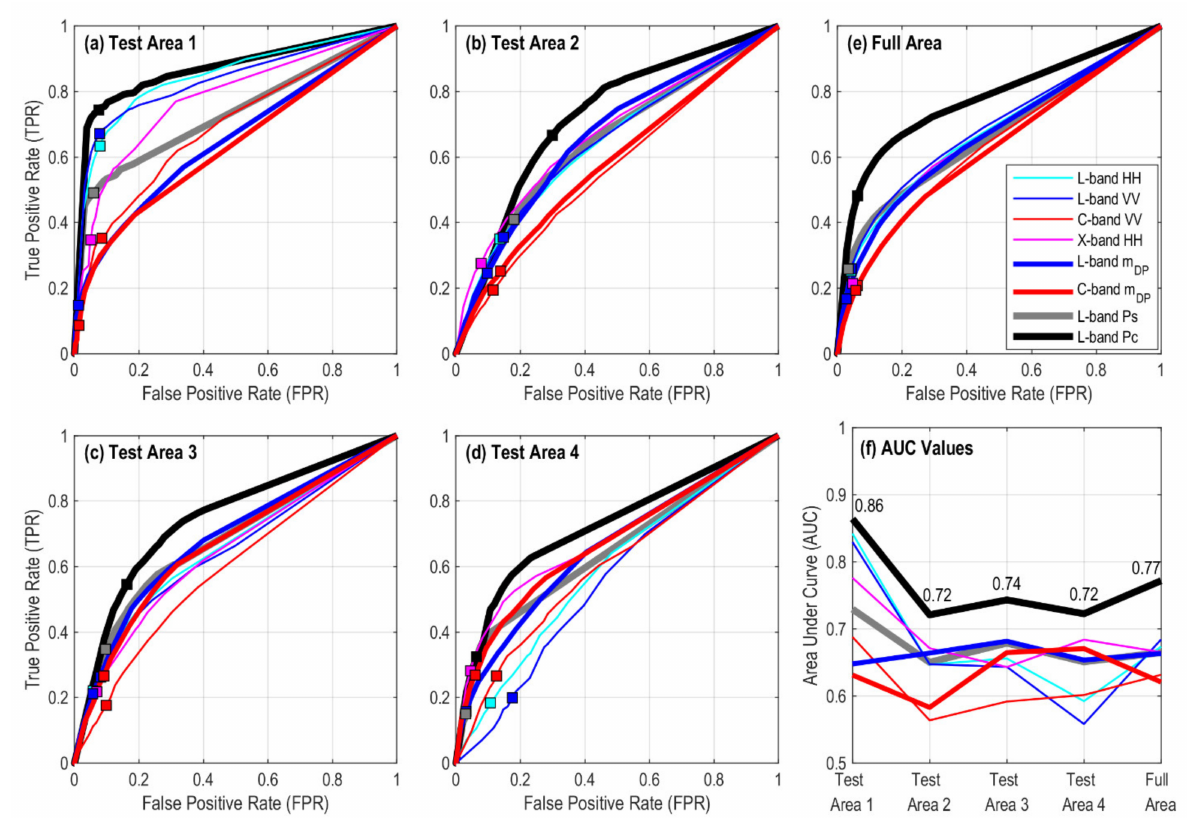
Figure 7. Receiver operating characteristics (ROC) curves and area under curve (AUC) for ( a – d ) the four test areas and ( e ) the full area of the Hokkaido AOI (Figure 3). The numbers shown in ( f ) the AUC plot are the values from the full-pol P c . Squares of different colors indicate the positions of the GSBA binary maps generated at a cutoff probability of